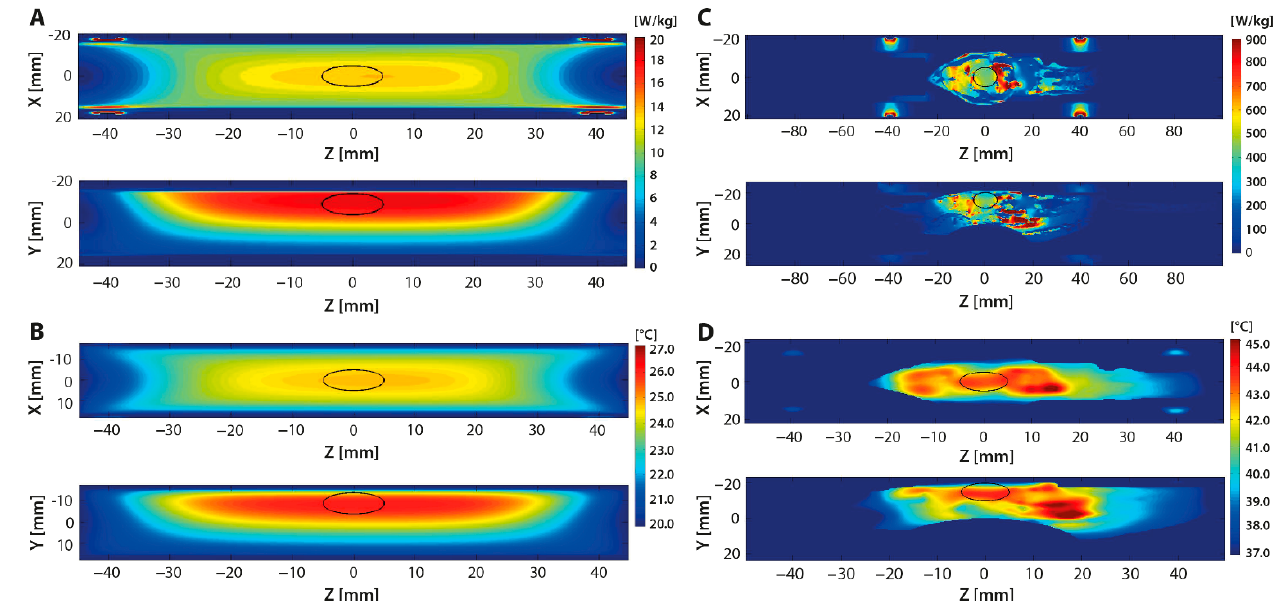
Figure 10. The specific absorption rate (SAR) and temperature distribution patterns of a homogeneous phantom ( A , B ) and mouse model ( C , D ) were simulated at fc = 433.92 MHz and Ψ = 60 ◦ . For the temperature distribution patterns, the following settings were applied: ( B ) P input = 20 W and t = 60 s; ( D ) P input = 34 W and t = 57 s. The thermoradiographs show the transverse (X,Z) and sagittal (Y,Z) planes of each measurement. The black oval represents the position of the tumor in the model.